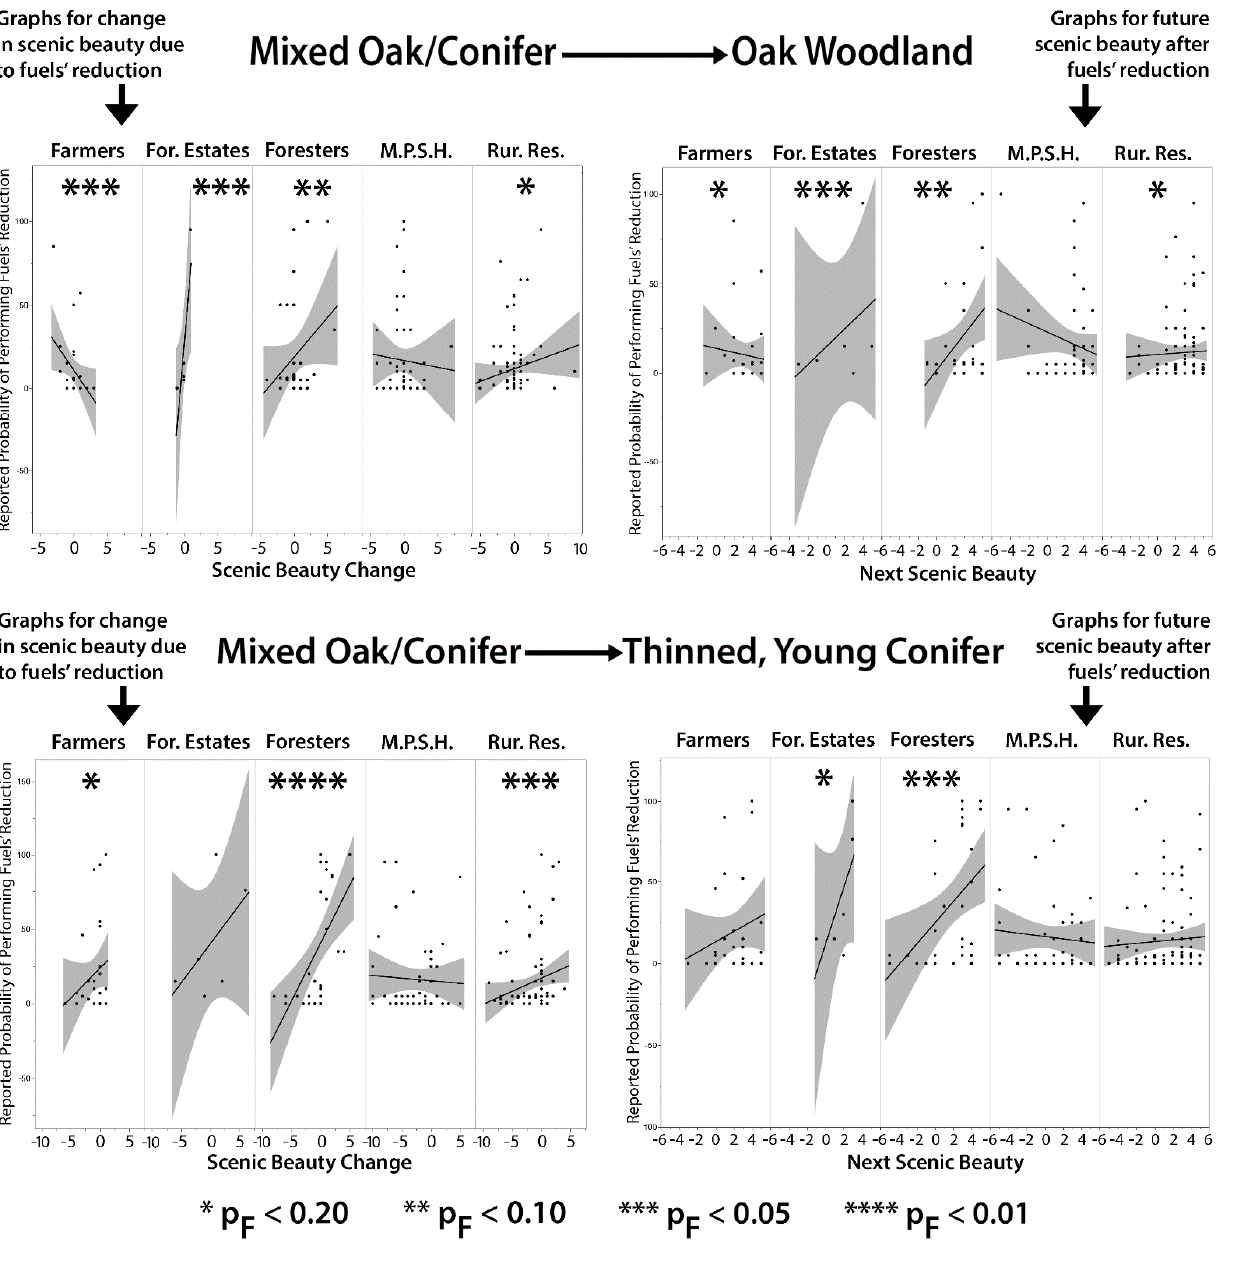
Figure 15. Landowner types in relation to scenic beauty correlations to fuels reduction propensities for two contrasting project types that begin with mixed forests.